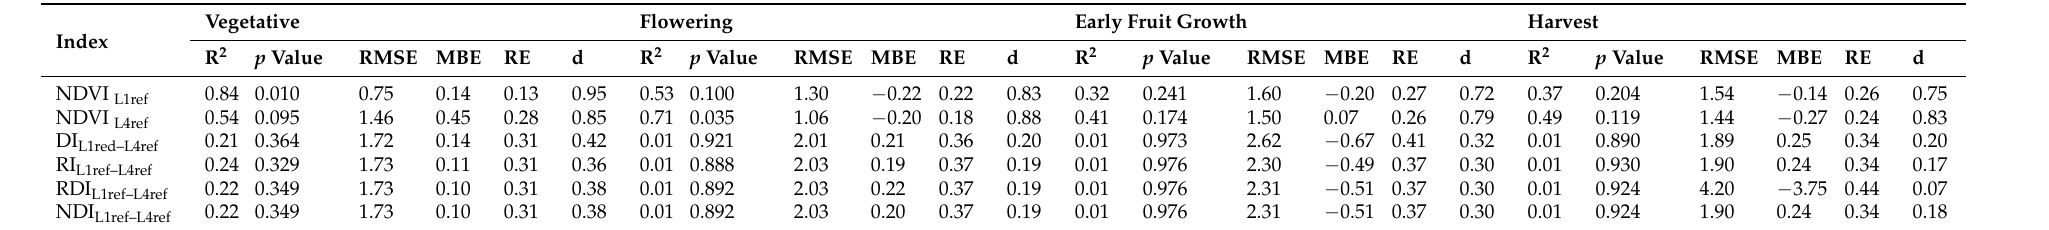
Table 10. Results of the validation analysis of the estimated fruit yield (kg m − 2 ) from NDVI measurements and several normalized NDVI indices (DI, RI, RDI, NDI), at different phenological stages of muskmelon. DI, Difference Index; RI, Relative Index; RDI, Relative Difference Index; NDI, Normalized Difference Index, R 2 , coefficient of determination; RMSE, root mean square error; RE, relative error; MBE, mean bias error; d, Willmott Index. L1ref and L4ref, refer to the latest (most recent) and fourth fully expanded leaf,